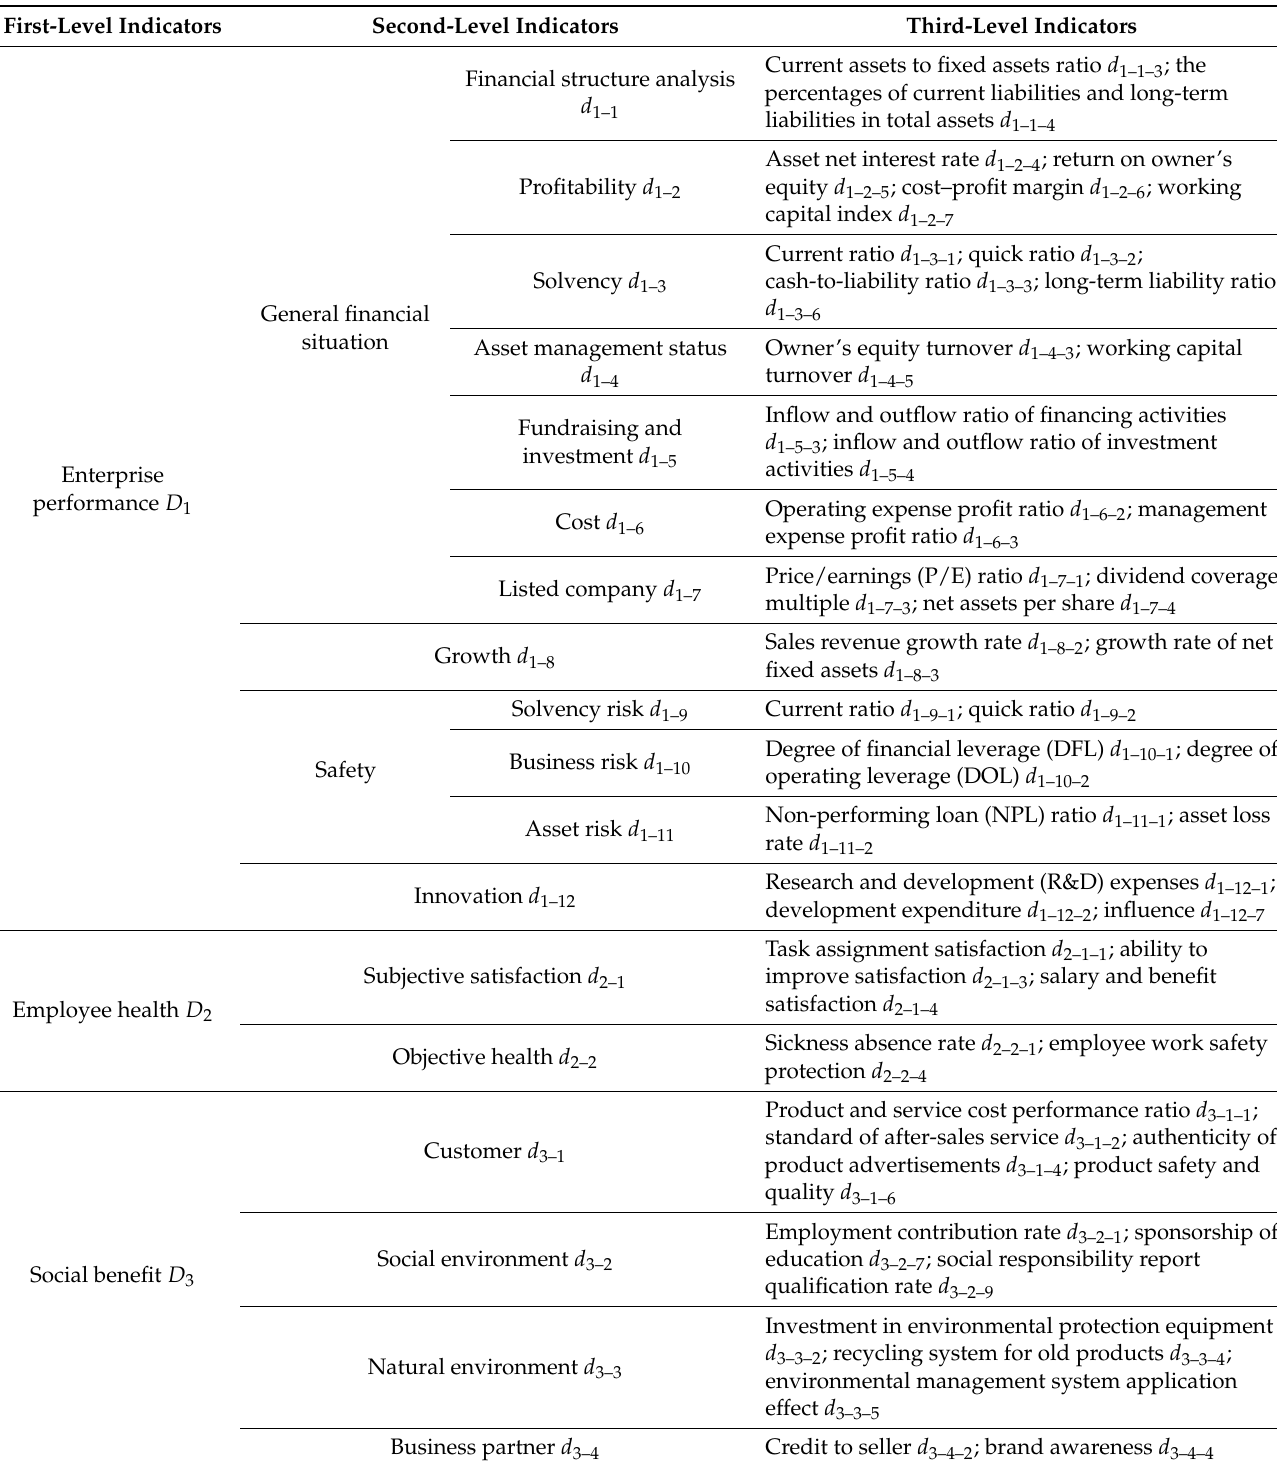
Table 10. Indicators for enterprise